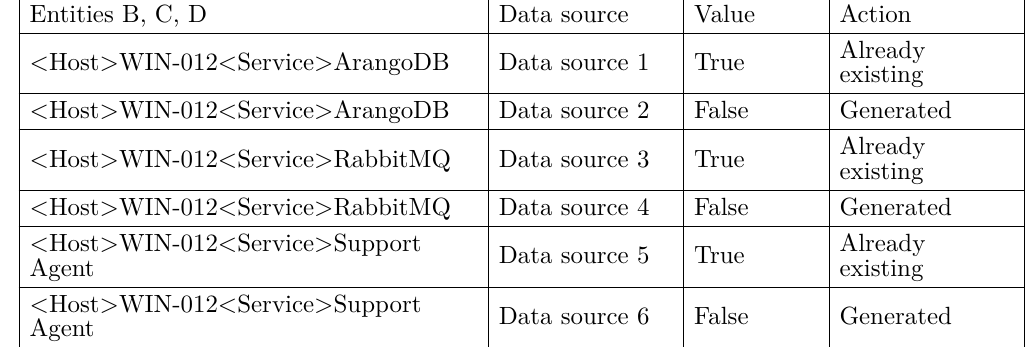
Table 3. Case Two: one-to-many relationship. All of the claims can be true or be negative (designated as false) Entities B, C, D Data source Value